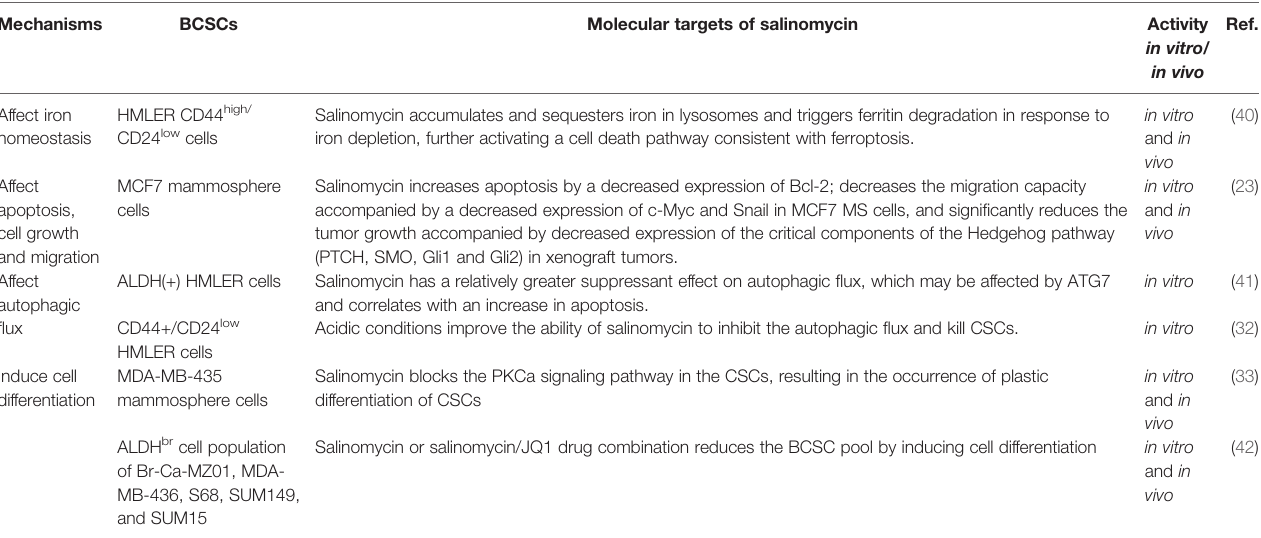
TABLE 1 | Anticancer mechanisms of salinomycin in BCSCs.